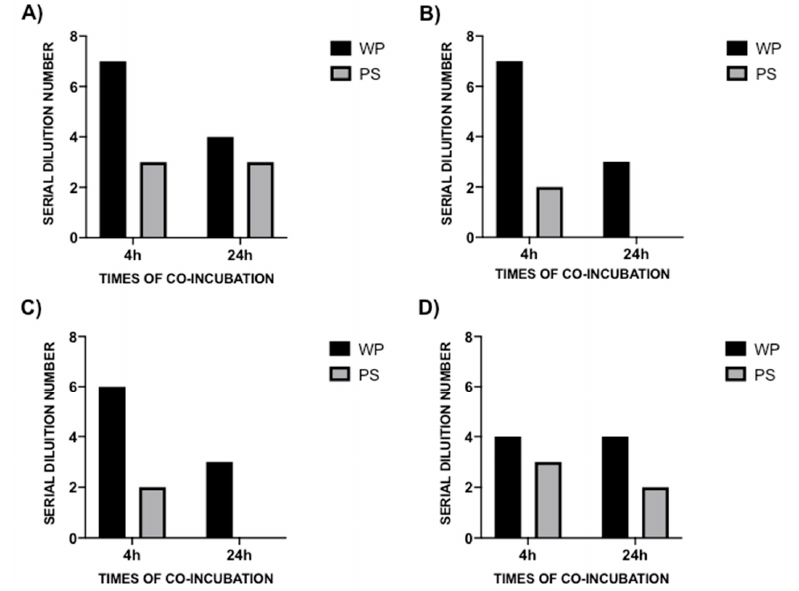
Figure 4. Antibacterial activity of probiotic whole compound (WP) and probiotic cell-free surnatant (PS) against clinical strains of carbapenem-resistant (CR) P. aeruginosa (Pa, A ), CR A. baumannii (Ab, B ), CR K. pneumoniae (Kp, C ), and methicillin-resistant S. aureus (MRSA, D ) at 4 h (black blocks) and 24 h (gray blocks) co-incubation times. The serial dilution number (y axis) corresponds to the number of the serial WP and PS dilutions needed to obtain the corresponding minimal bactericidal dilution (MBD). Results were expressed as mean. Standard deviation (SD) is not graphically represented since the values of the experiments (performed in duplicate) were the same.